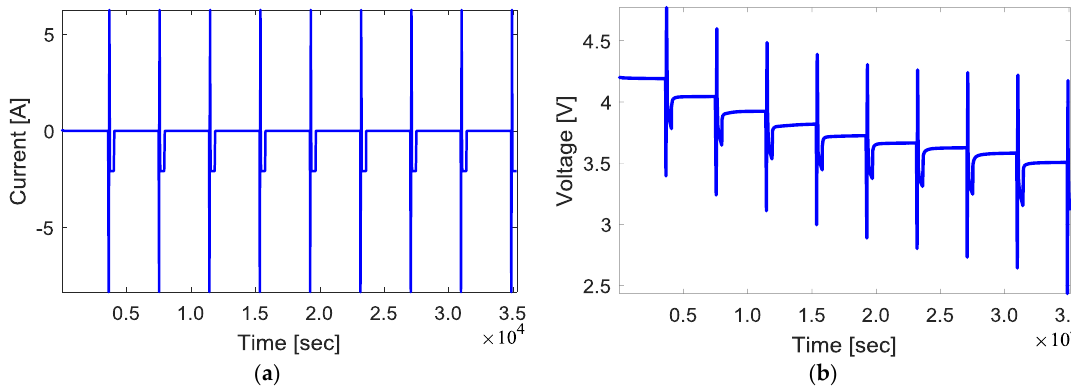
Figure 6. ( a ) Current profile; and ( b ) terminal voltage of HPPC test for the parameter identification.